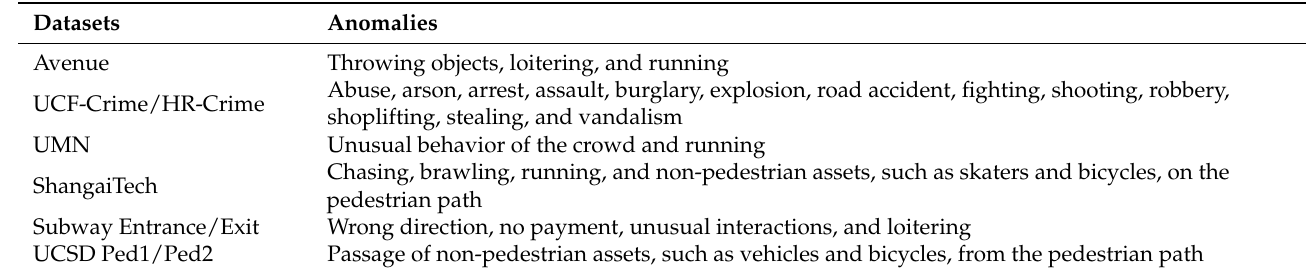
Table 9. Anomalies of SVAD